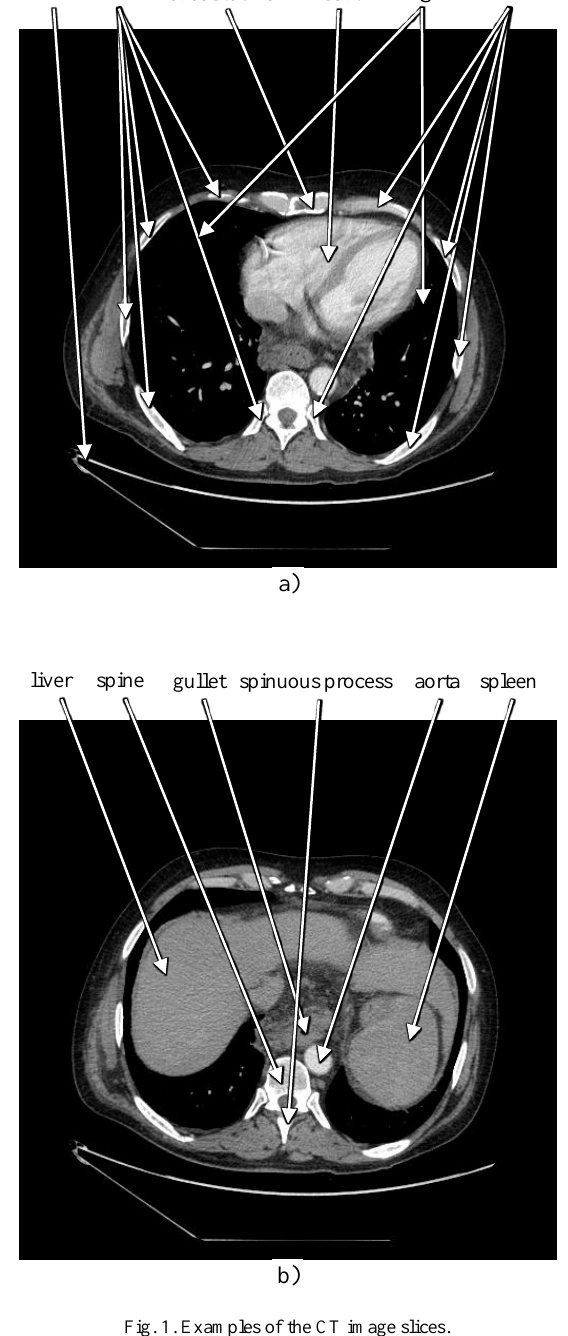
Fig. 3. Thick line – standard cardioid (1), middle thickness and thin lines – (2) curve with 𝑠 = 0.5 and 𝑠 = 0.3 ,